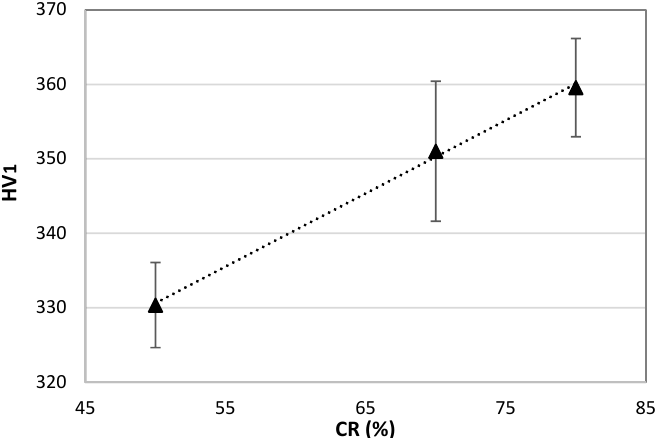
Figure 2. AISI 904L cold-rolled steel. ( a ) CR: 50%; ( b ) CR: 70%; ( c ) CR: 80%.